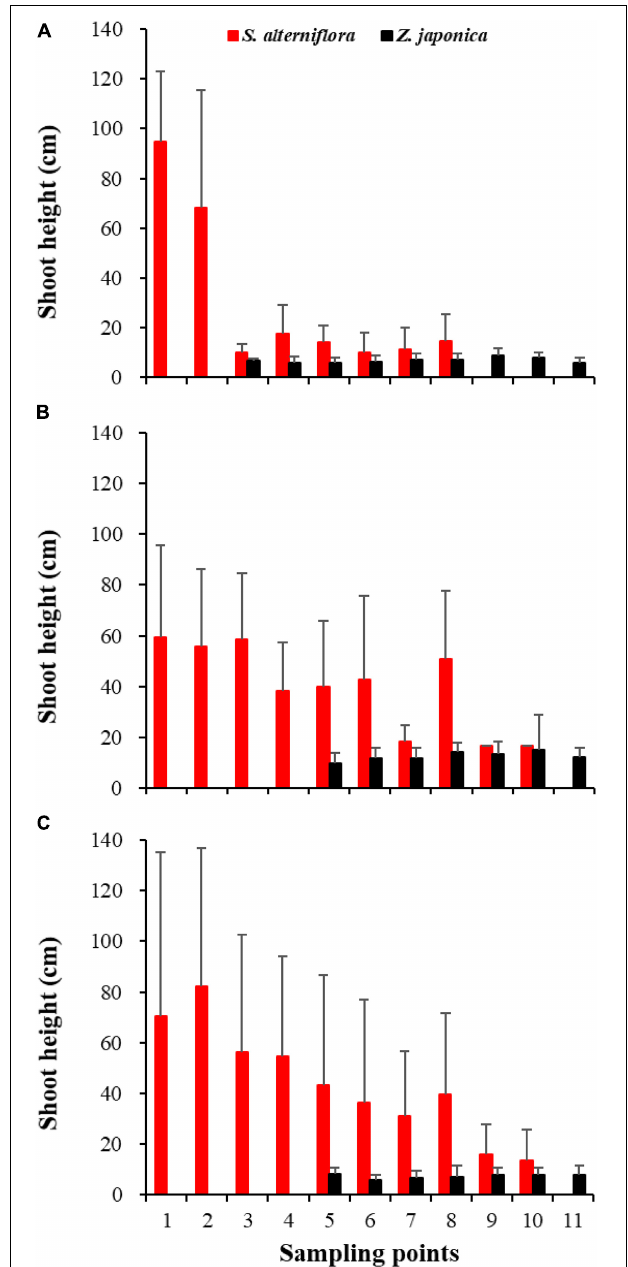
FIGURE 5 | Biomass of Spartina alterniflora and Zostera japonica at the 11 sampling points in April (A) , July (B) , and October (C) 2019. Values are mean ± SD.